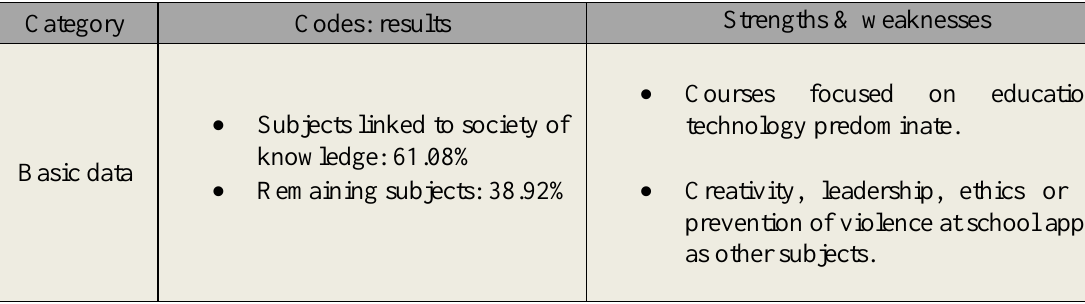
Table 3 Results of the Pedagogic Analysis: Findings and Limitations